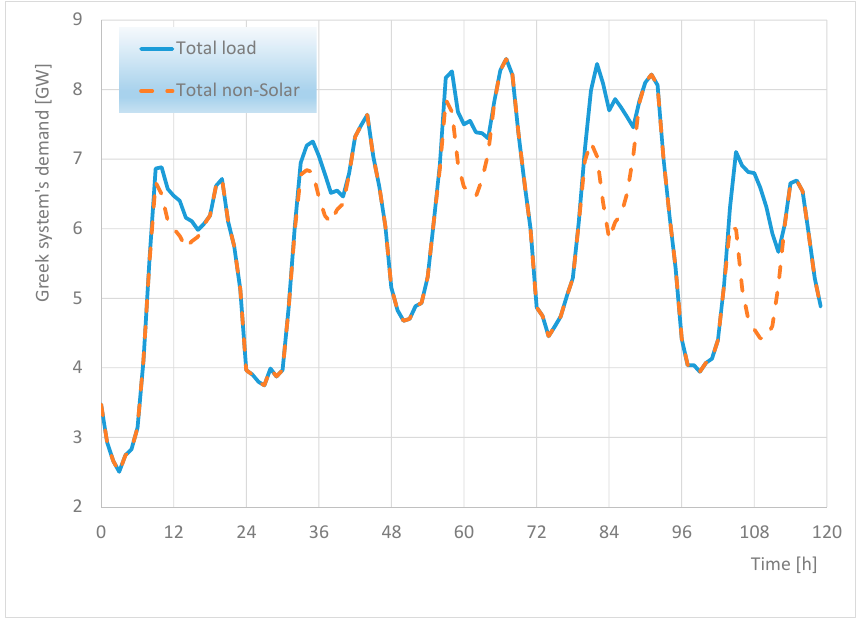
Figure 16. Load demand of the Greek system in the period 10–14 January 2022; the demand covered by non-solar power sources is indicated for comparison.